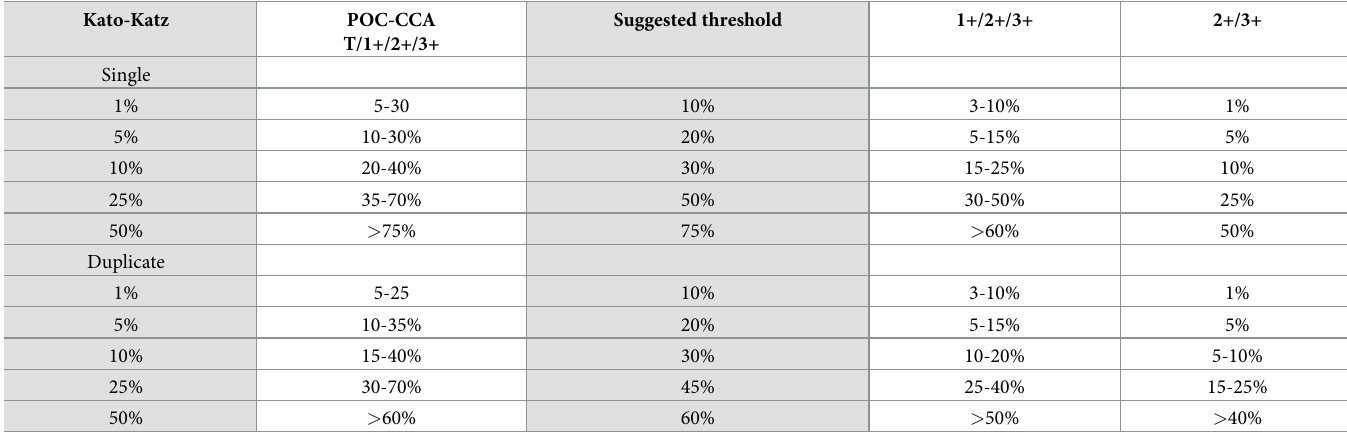
85% and determined a relation between Kato-Katz and POC-CCA prevalence for true preva- lence above 35%. Caveats of their analysis are as follows. First, the semi-quantitative readings were modeled by a binomial distribution, which is not supported by the process generating the data. Second, POC-CCA positive but egg-negative individuals were defined as negative, Table 5. Estimated equivalent prevalence of POC-CCA to single and duplicate slide Kato-Katz and suggested equivalent prevalence threshold. Kato-Katz POC-CCA